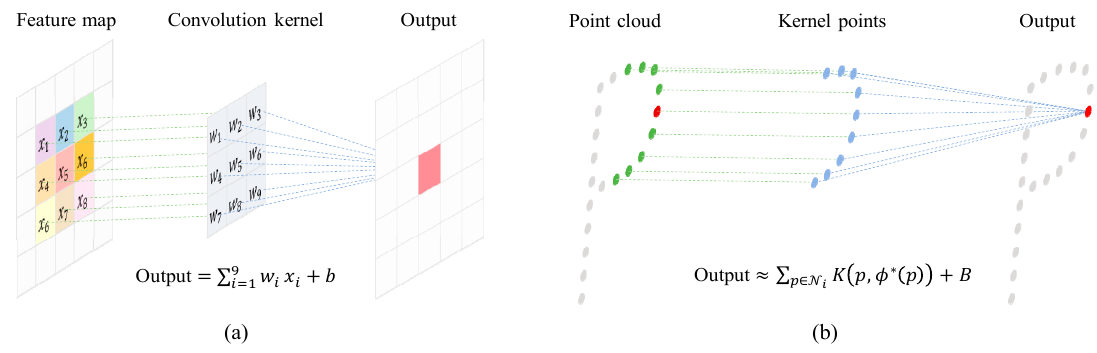
Figure 3. Illustration of 2D convolution and SAC. (a) Illustration of the convolution on the 2D image, which can be represented as a weighted combination of the neighboring pixels’ features ( The standard convolution should first transpose the convolution kernels and then multiply them with the corresponding pixels. We omit the transposition process here for denotation convenience. ); (b) Illustration of the proposed SAC on the 3D point cloud. Kernel points are matched with neighbors of each point; the point with a local geometric structure similar to the kernel is activated. Both the 2D convolution and our SAC aim at detecting specific patterns in images or point clouds. However, the patterns are reflected by changing gray values in images, but are shown by spatial coordinates in point clouds.